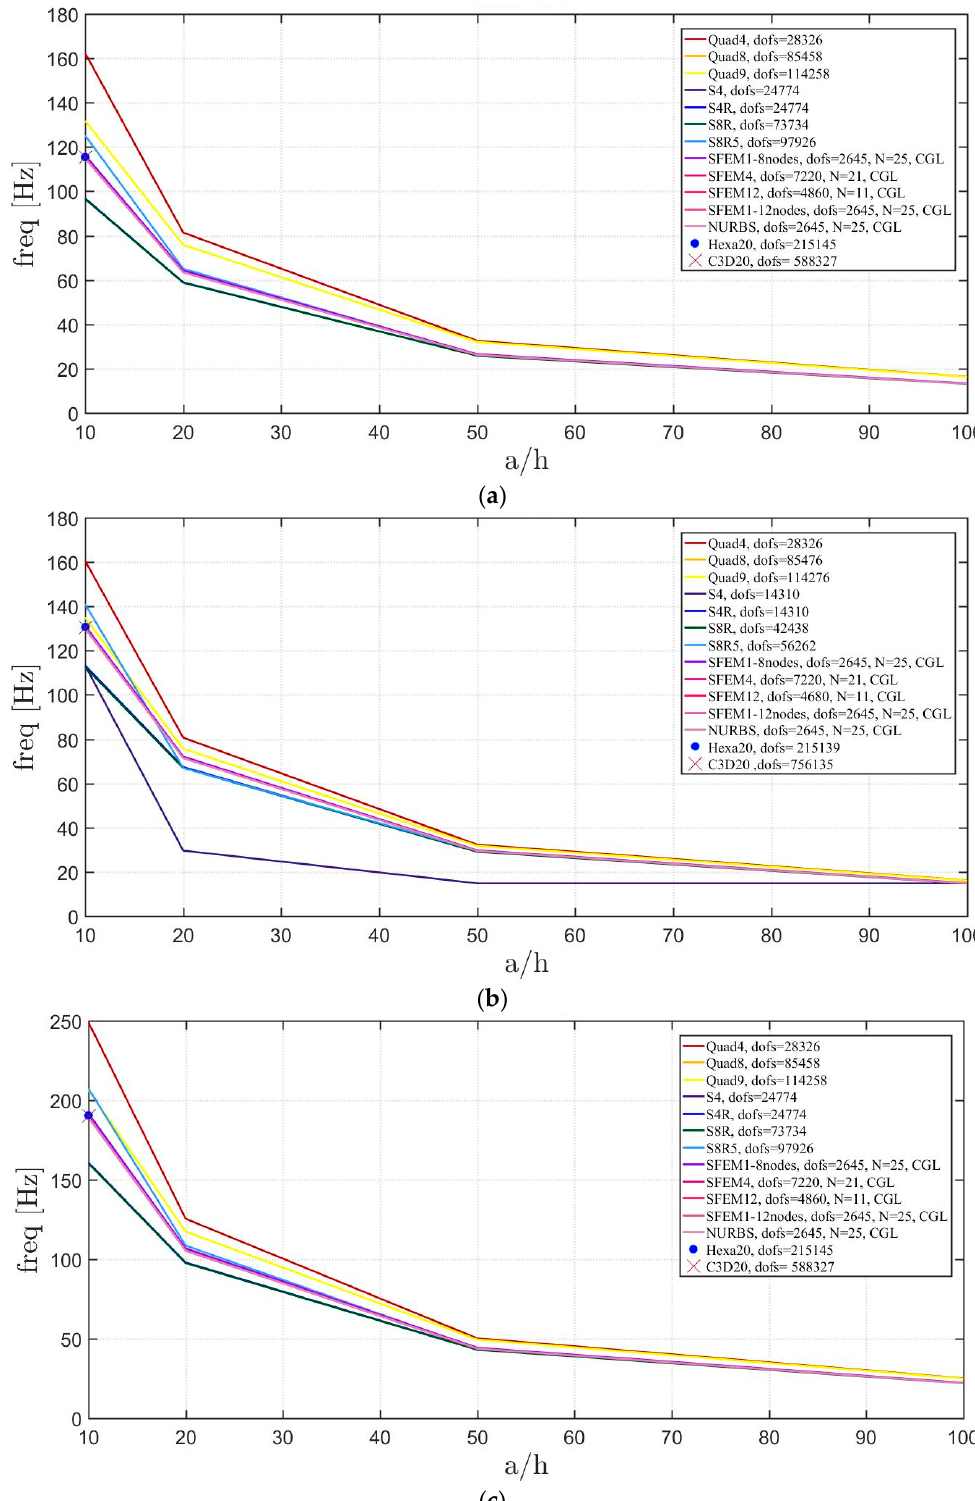
Figure 34. Thickness effect on the first three natural frequencies of an elliptic plate a / b = 2.5 with a not-symmetric lamination scheme: ( a ) First frequency; ( b ) Second frequency; ( c ) Third frequency.